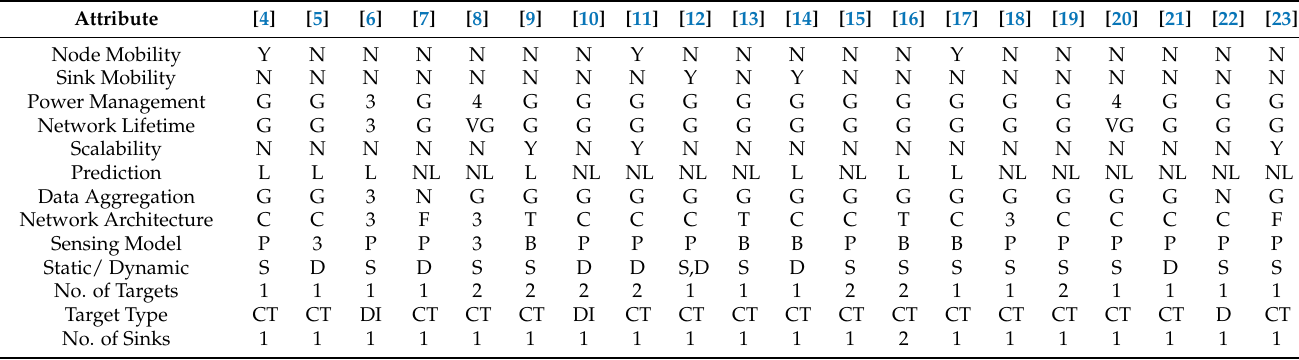
Table 2. Comparative Study of Past Research-I.